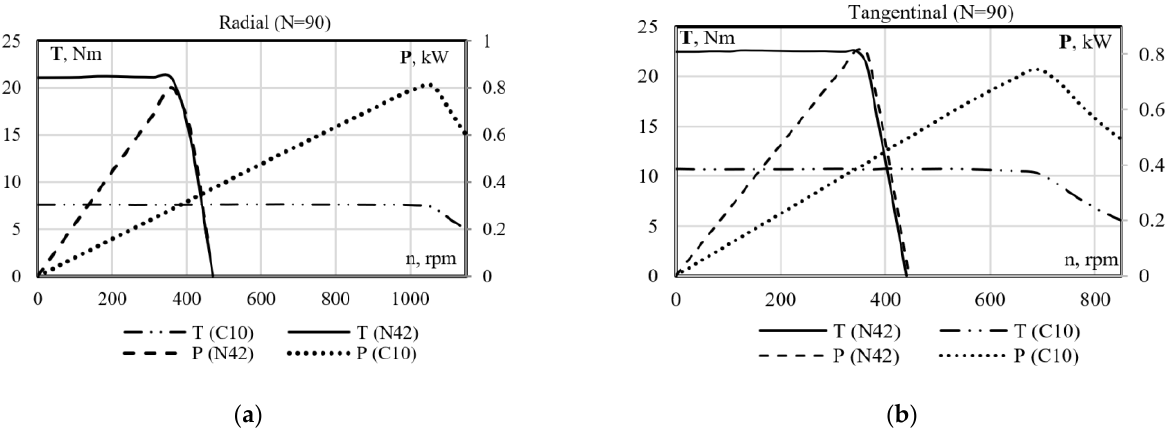
Figure 3. Electromechanical characteristics of the tangential and radial machines with N42 and C10 PMs for N = 90 turns. Here, the X -axis defines the speed of the machines and the Y -axis shows the torque and output power.